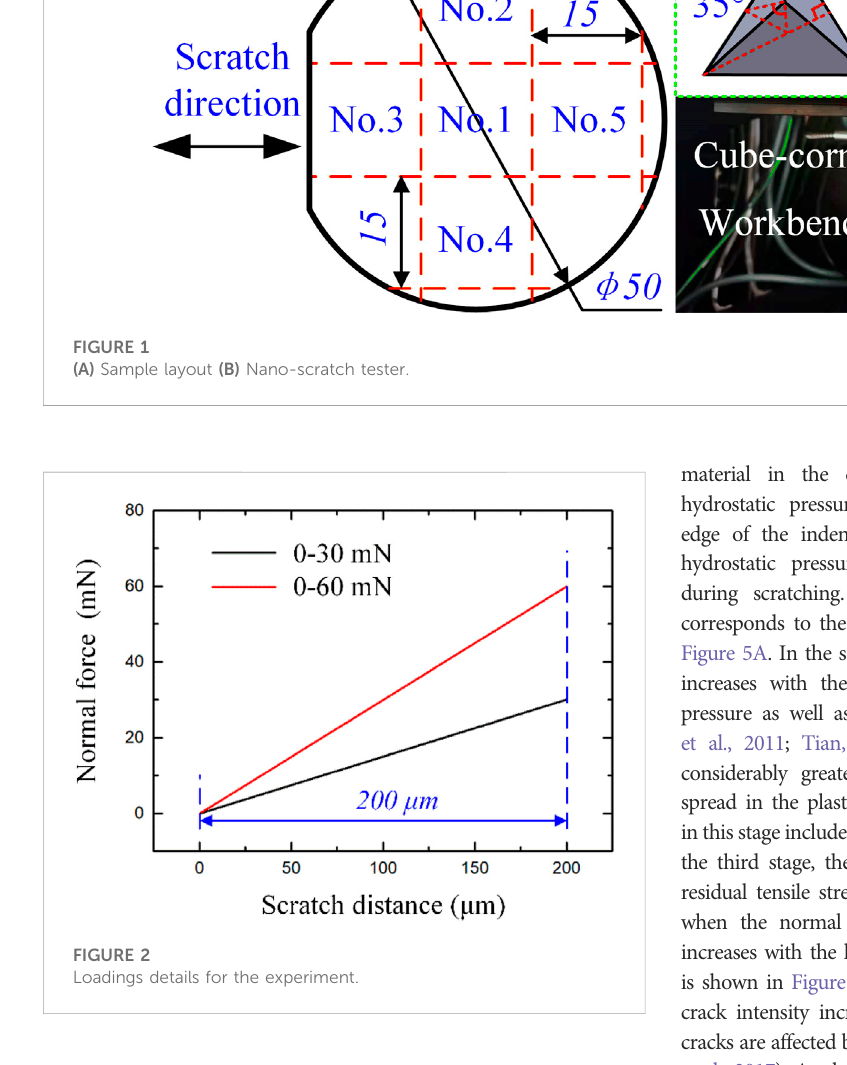
FIGURE 2 Loadings details for the